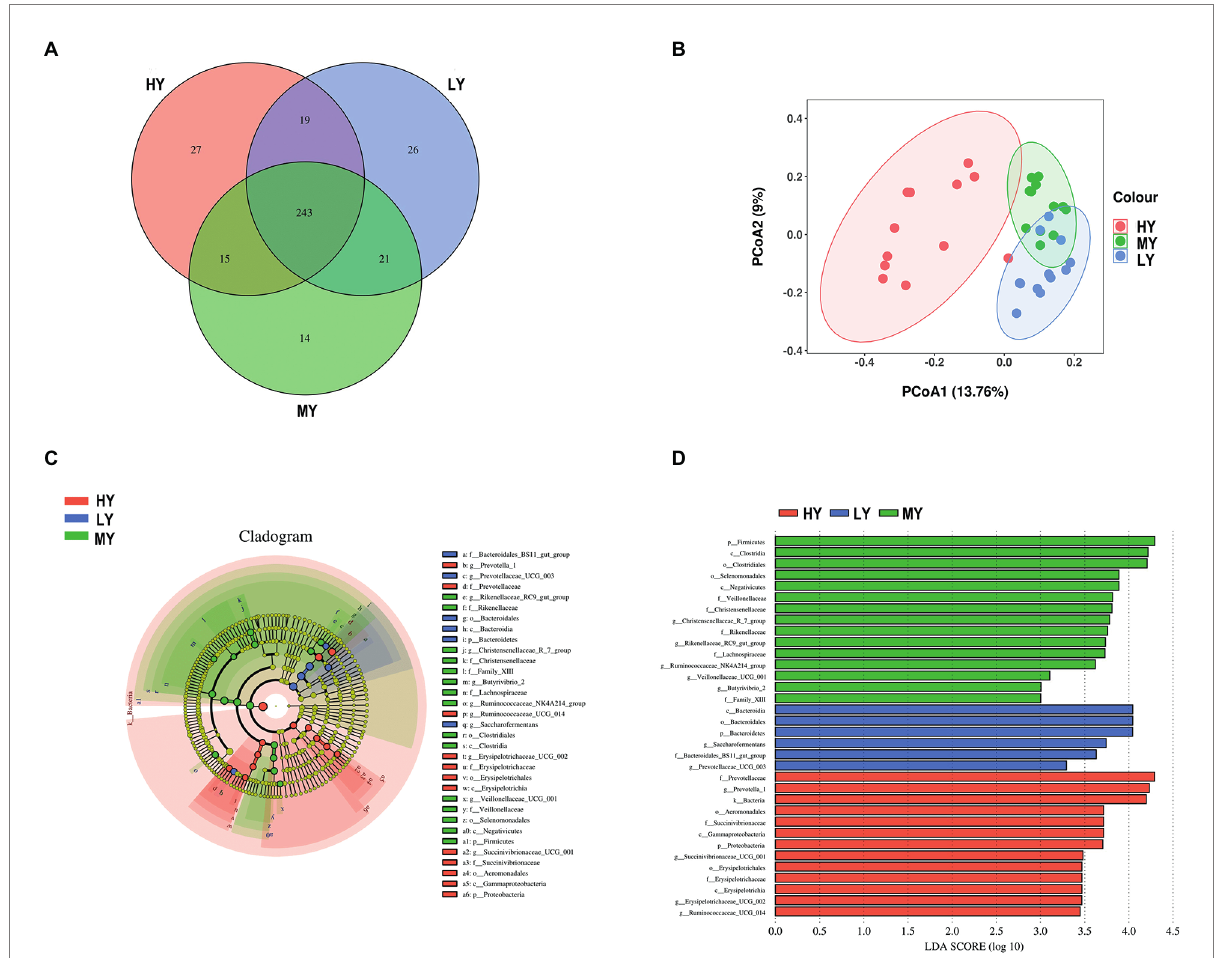
FIGURE 2 Venn diagrams (A) and PCoA plots (B) of the rumen bacterial community for the different ME:N ratios. LEfSe analysis of the bacterial community for the different ME:N. Cladogram (C) showing significantly enriched bacterial taxa from phylum to genus level. In the histogram (D) , the red color illustrates that the abundance of taxa was highest in the high ME:N (0.42 MJ/g); the green color illustrates that the abundance of taxa was highest in the medium ME:N (0.36 MJ/g); and the blue color illustrates that the abundance of taxa was highest in the low ME:N (0.32 MJ/g). HY, high ME:N (0.42 MJ/g); MY, medium ME:N (0.36 MJ/g); LY, low ME:N (0.32